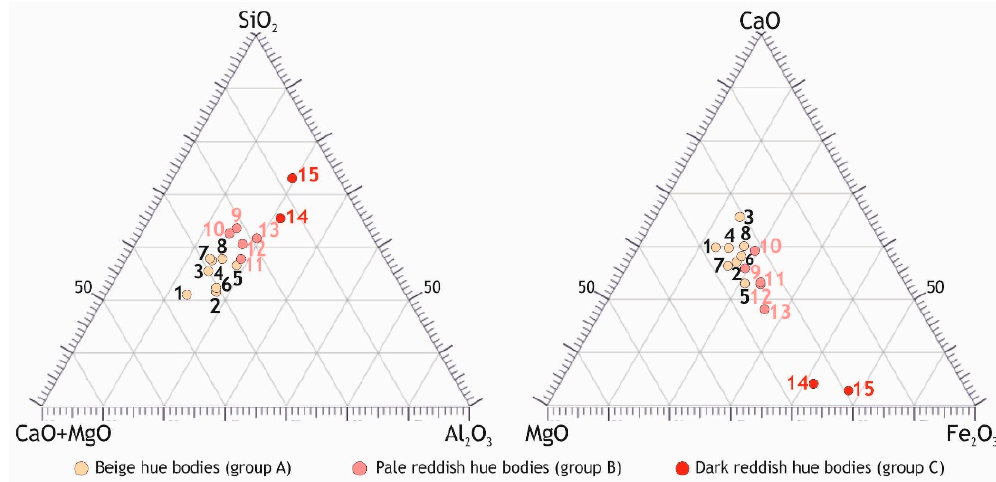
Figure 5. Ternary diagrams SiO 2 –Al 2 O 3 –CaO + MgO ( left ) and CaO—Fe 2 O 3 –MgO ( right ) with the plot of the composition of the bricks, identified according to their color. Sample numbered according to Tables 1 and 2.